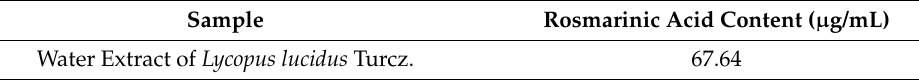
Table 1. Rosmarinic acid content of Lycopus lucidus Turcz. extract.